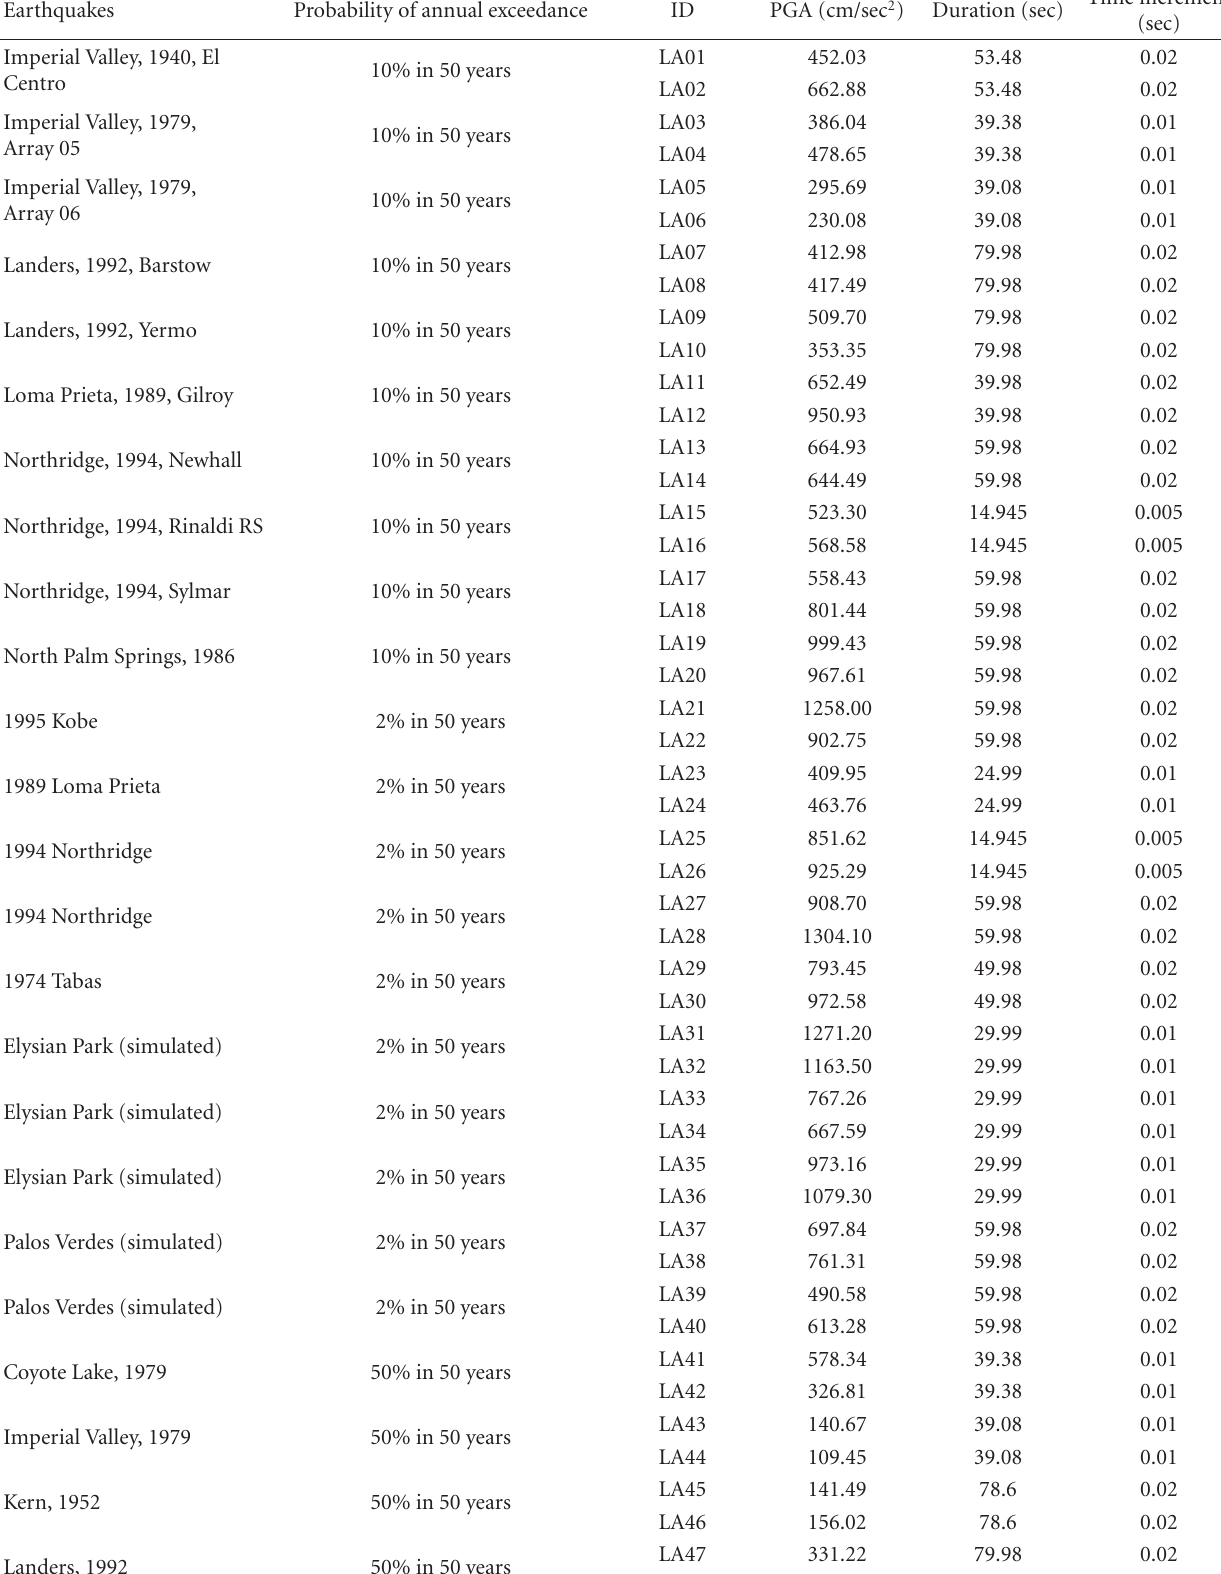
Table 1: 60 LA ground